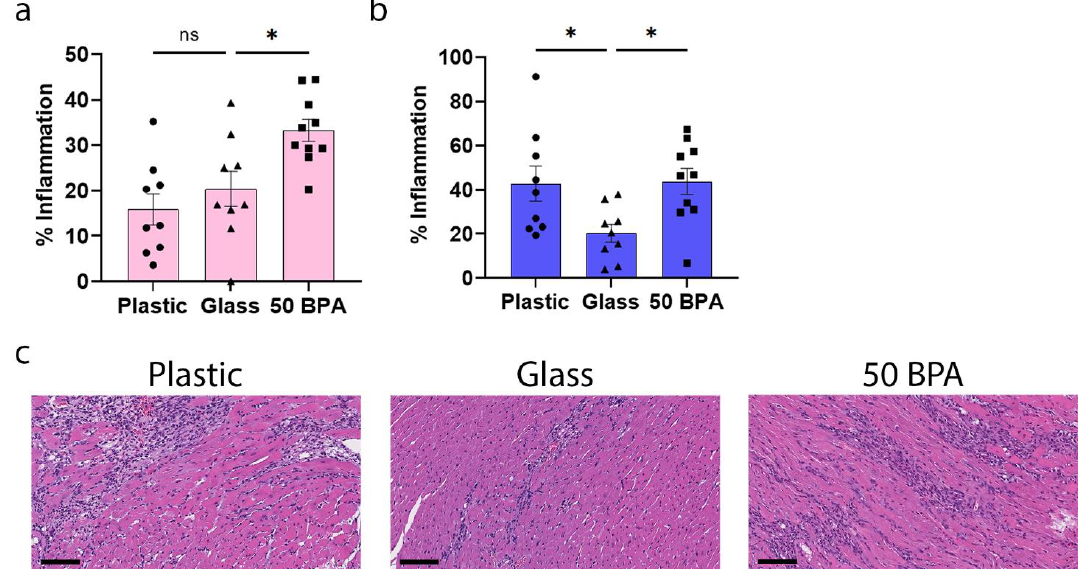
Figure 1. Plastic caging increases myocardial inflammation during acute myocarditis in male BALB/c mice. ( a ) Female (pink) and ( b ) male (blue) BALB/c mice were given normal drinking water (drinking water that did not contain BPA) for 2 weeks and housed either in glass cages/water bottles (glass) or plastic cages/water bottles (plastic) with soy-free food and bedding, or BALB/c mice housed in glass cages/water bottles with soy-free food and bedding were either given normal drinking water (drinking water that did not contain BPA) (glass) or 250 µ g BPA/L water (50 BPA) for 2 weeks. After BPA exposure, mice received an intraperitoneal (i.p.) injection with 10 3 plaque-forming units (PFU) of CVB3 on day 0 and harvested at day 10 post infection (pi). Myocarditis was assessed as % inflammation compared to the total size of the heart section with H&E using a microscope grid. Data shown as scatter plot and mean +/ − SEM using one-way ANOVA with Holm –Šídák’s multiple comparisons test with 9 – 10 mice/group (* p < 0.05). ( c ) Representative H&E images of cardiac inflammation in plastic caging (plastic), glass caging (glass) or with 50 BPA in drinking water (50 BPA) (magnification 200×, scale bar 100 μ m).